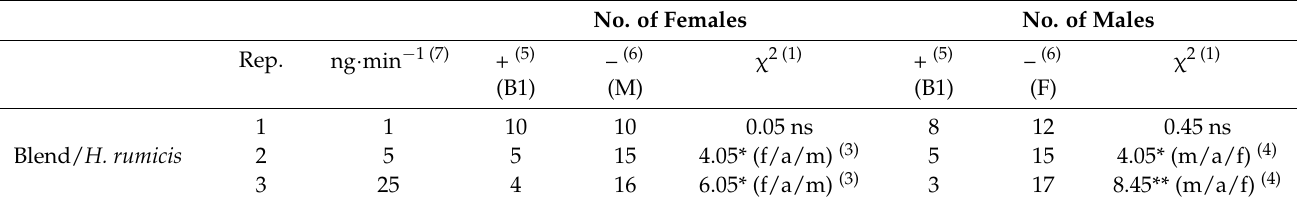
Legend: (1) level of significance (ns–not significant), (* p < 0.05), (** p < 0.01), (3) f/a/m—females attracted to male, (4) m/a/f—males attracted to female, (5) + Y-tube arm with tested amount of the compounds, volatile diluted in